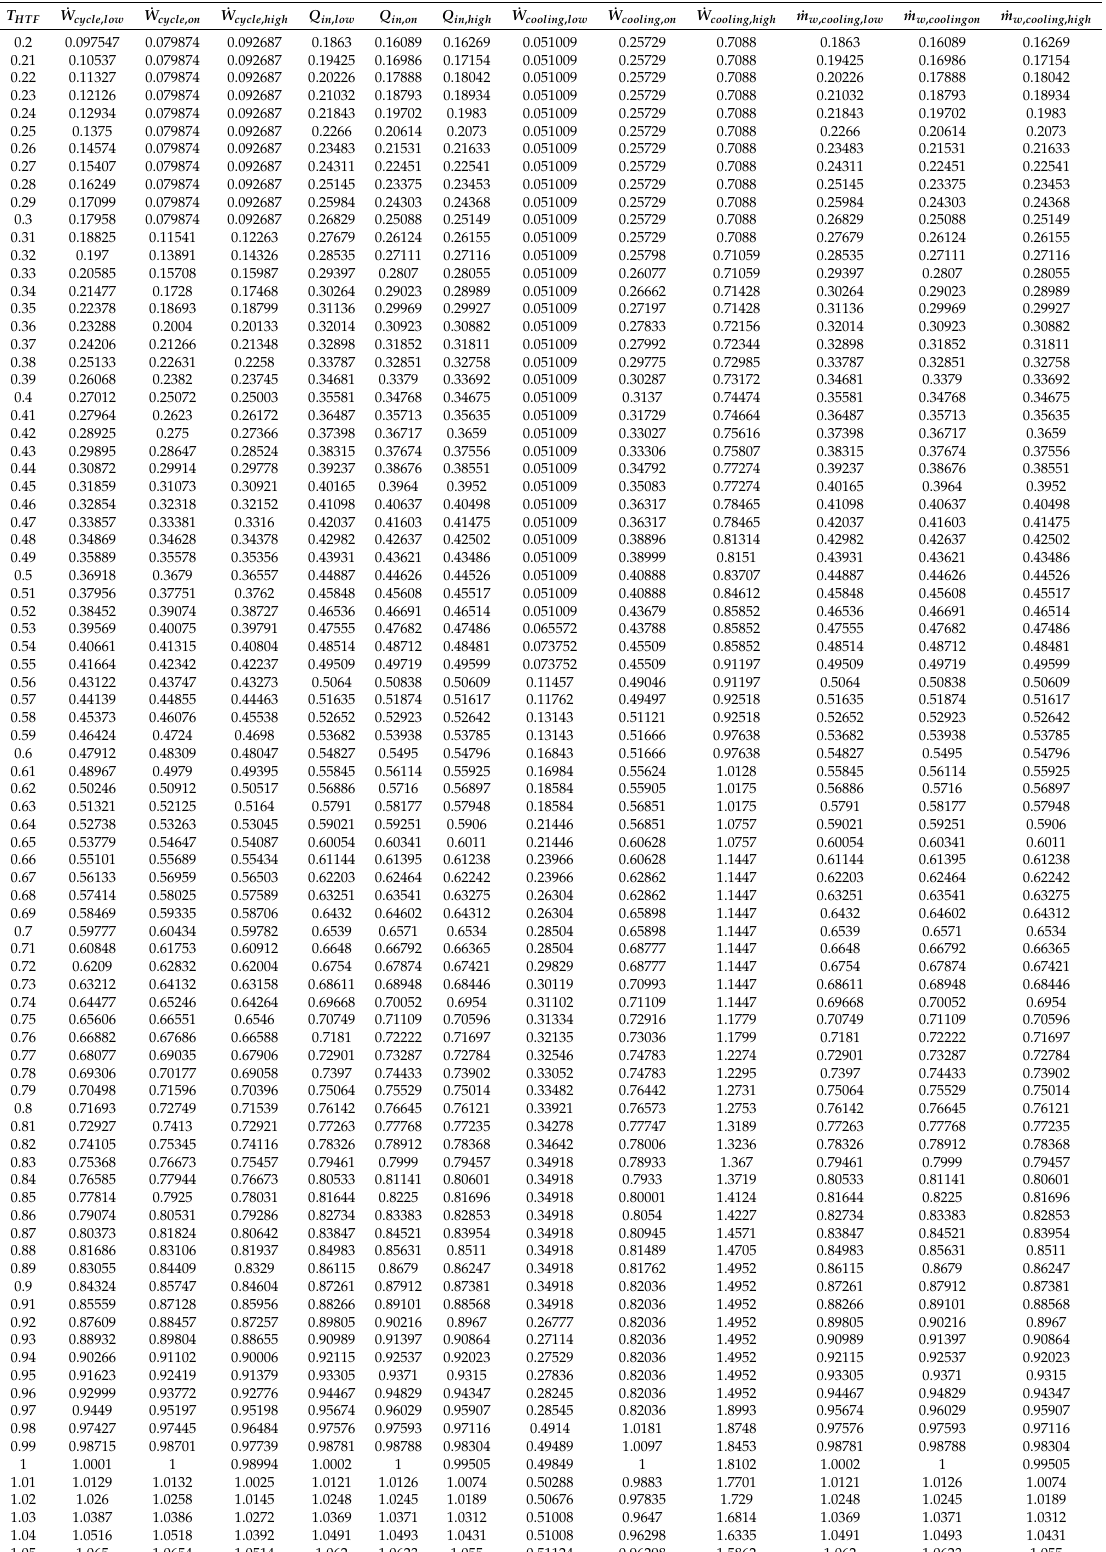
Table A5. Performance as a function of HTF mass flow rate (MOD2) table for Partial Cooling cycle. “Low”, “On” and “High” respectively refer to the three values of ambient temperature employed: 5, 15 and 40